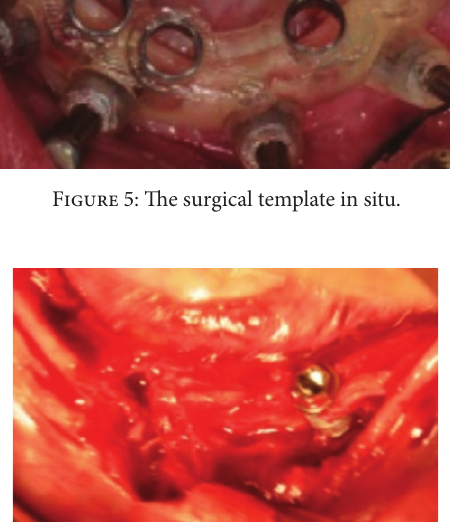
Figure 9: All the five implants placed free hand.